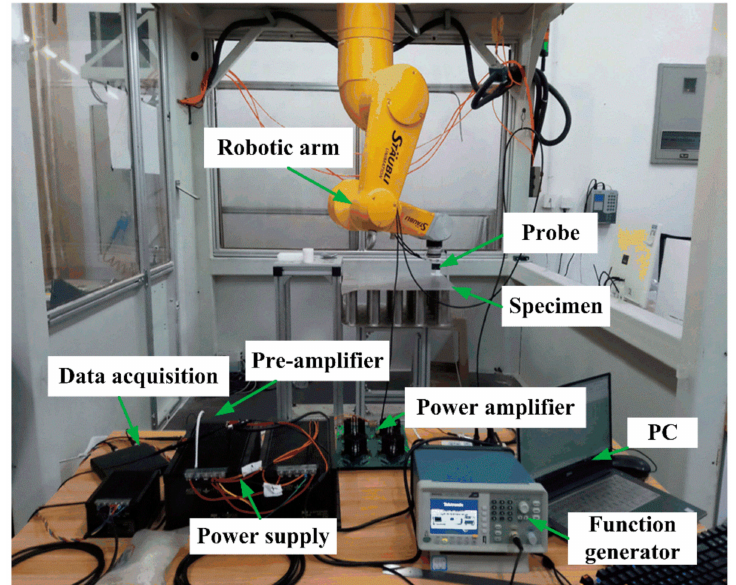
Figure 8. Photo of the PECT experimental set-up.